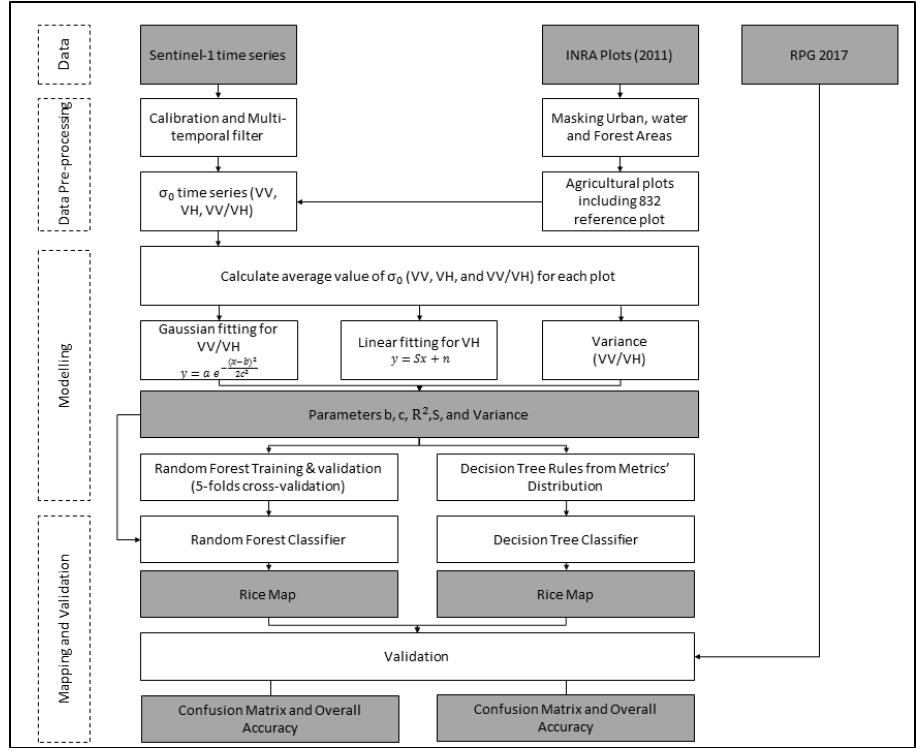
Figure 3. Workflow overview using a decision tree and Random Forest (RF) Figure 3: Workflow overview using a decision tree and Random Forest (RF) classifier